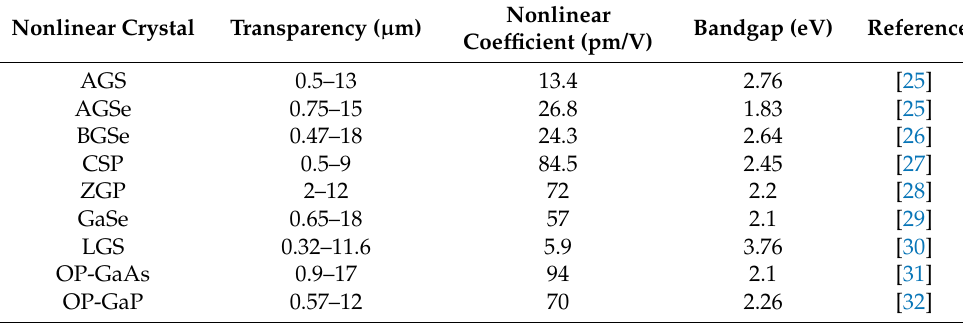
Table 1. Comparison of different MIR nonlinear